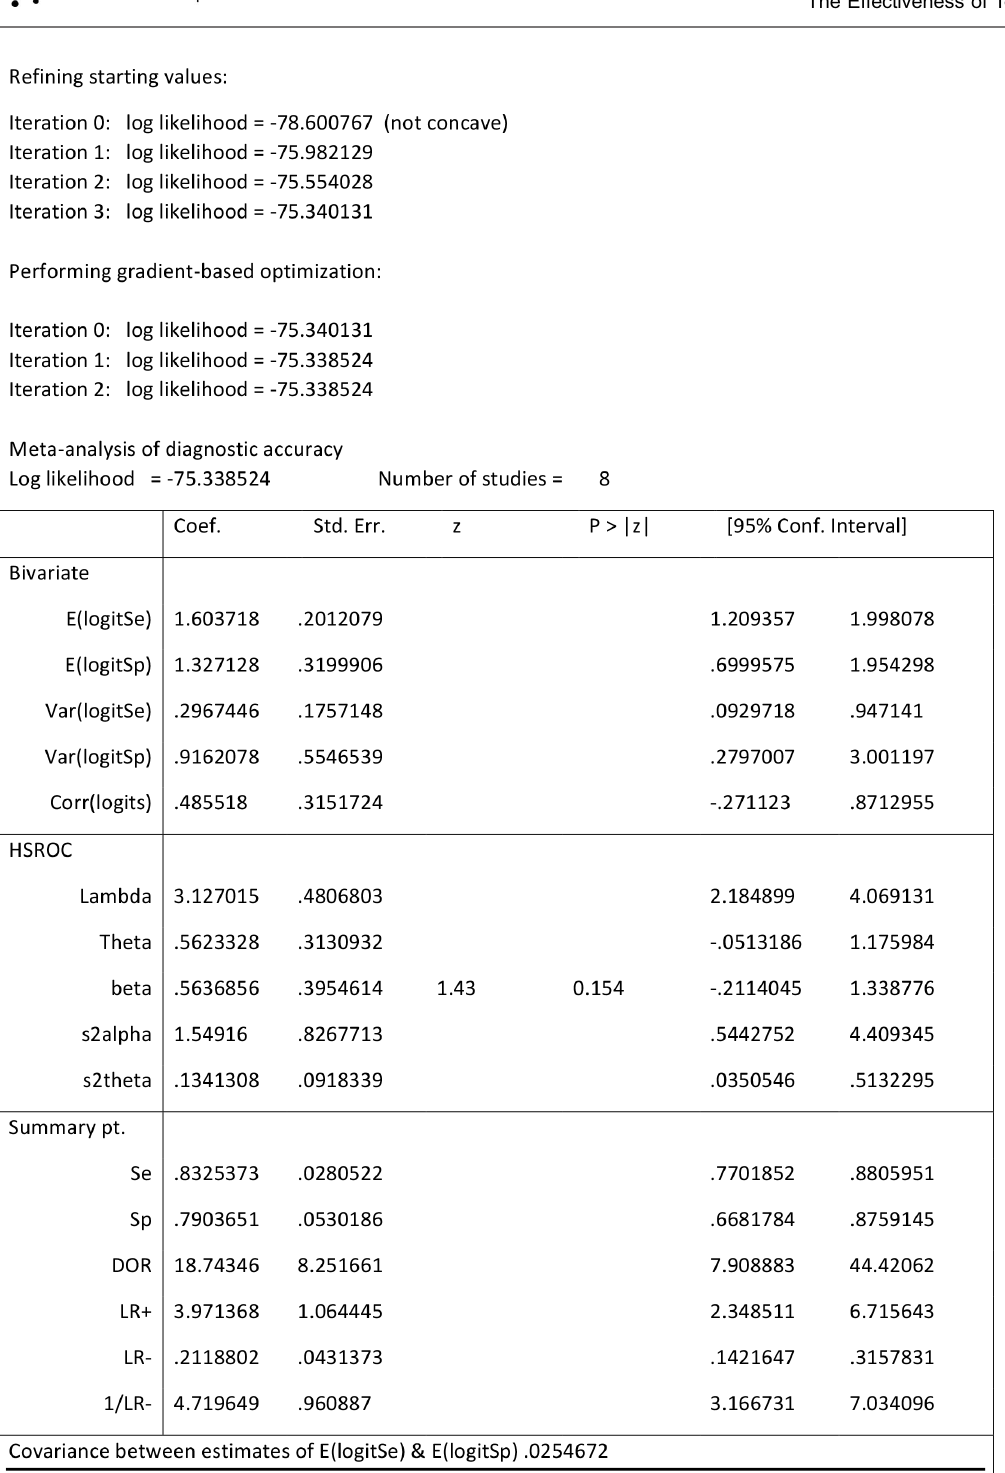
Figure 2. Hierarchical logistic regression results.